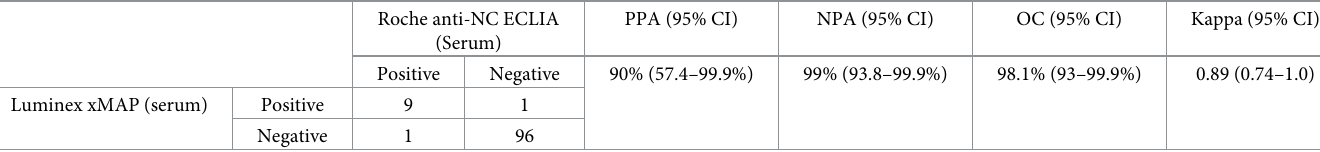
Table 3. Result comparison between 107 serum samples tested by the Luminex xMAP and Roche anti-NC ECLIA anti-SARS-CoV-2 serologic